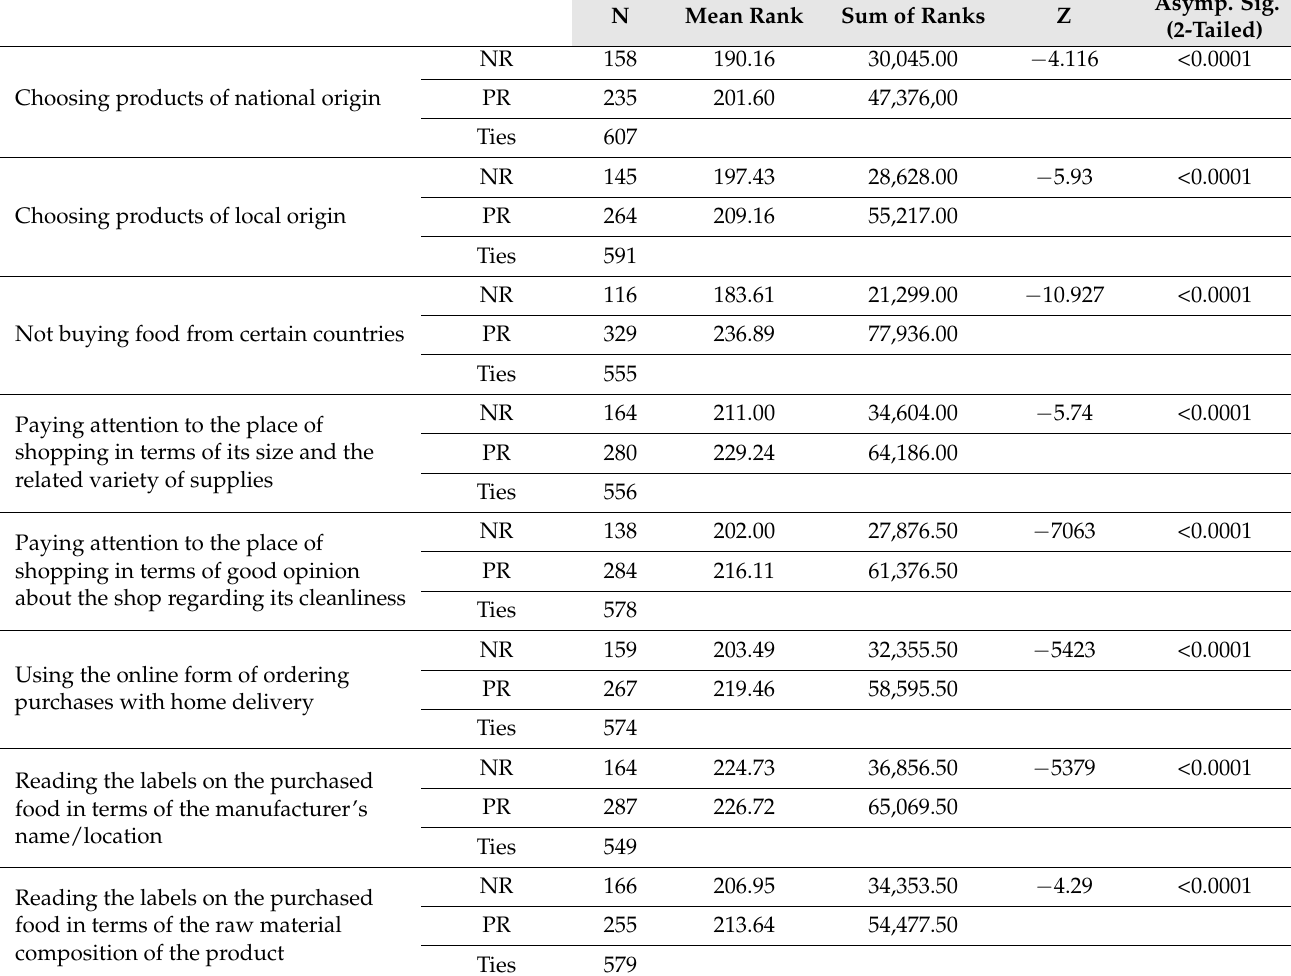
Table 6. Assessment of consumer attitudes before and during the pandemic. N Mean Rank Sum of Ranks Z